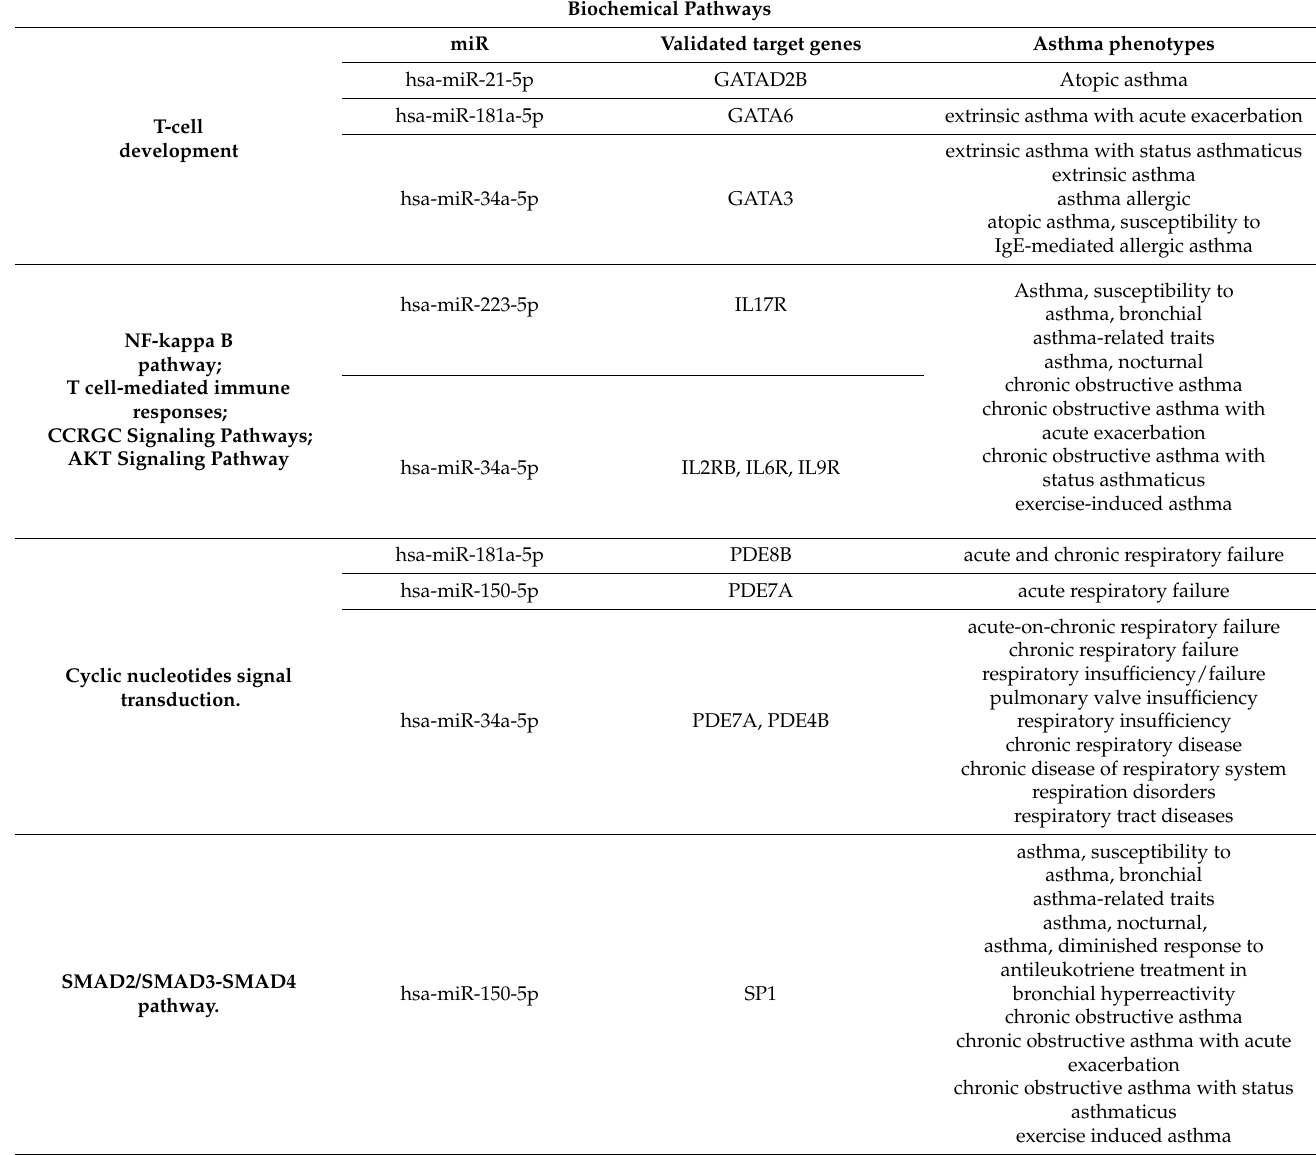
Table 4. Biochemical pathways and possible miRs gene